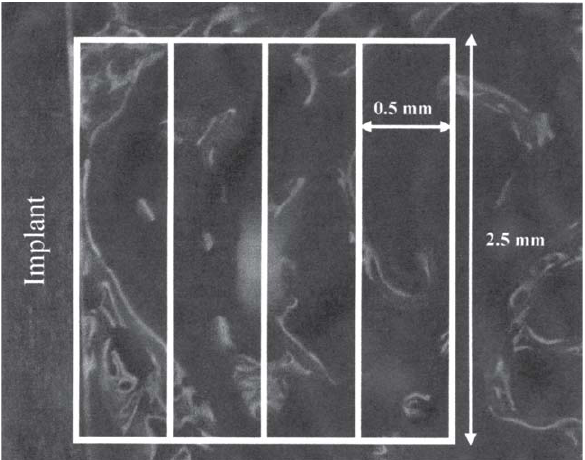
FIGURE 1- Representation of a micrograph (at 40x original magnification) subdivision into 0.5 mm base by 2.5 mm height rectangles for quantification of tetracycline labeled bone area fraction